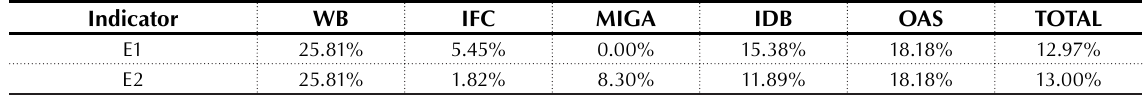
Table 12. Indicators of non-financial assistance for financial inclusion,